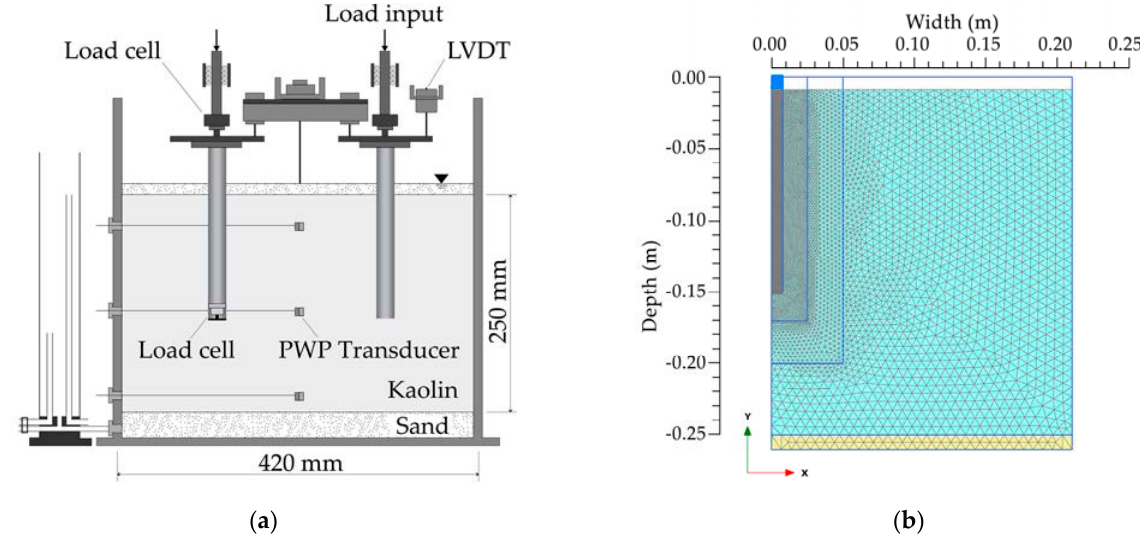
Figure 5. Experimental setup for centrifugal model test: ( a ) 1:100 scale model of two piles, placed in the centrifuge; ( b ) mesh model for centrifugal model verification.